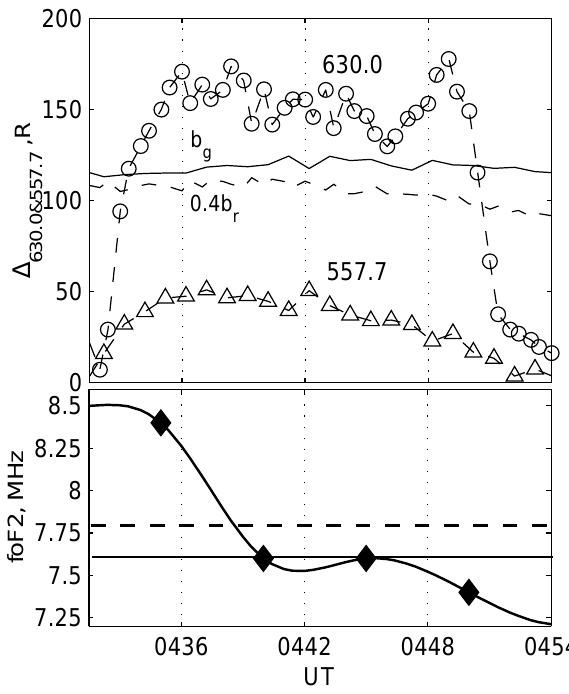
Fig. 4. Heater-induced red- and green-line emissions during the long pulse on 13 February 2002. Solid and dashed lines show in- tensities of the background green ( b g ) and (scaled) red ( b r ) emis- sions, respectively. (bottom) The critical frequency of the F-layer above the HAARP site (diamonds); the solid line represents a spline approximation; dashed and dotted lines show the heating frequency and the plasma frequency at H mz , respectively.